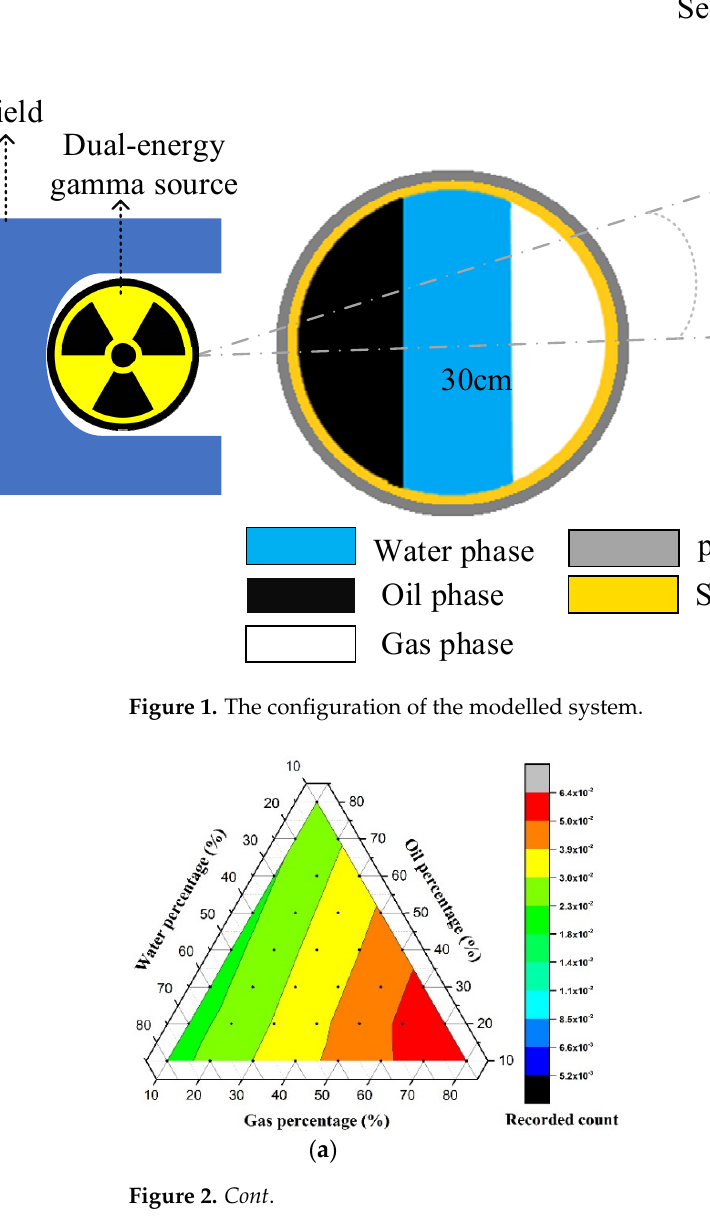
Figure 2. Recorded counts under Photopeaks of ( a ) 241 Am and ( b ) 133 Ba radioisotope in the second detector for different combed oil, gas and water volume fractions at thickness scale of 0 cm. ( a )